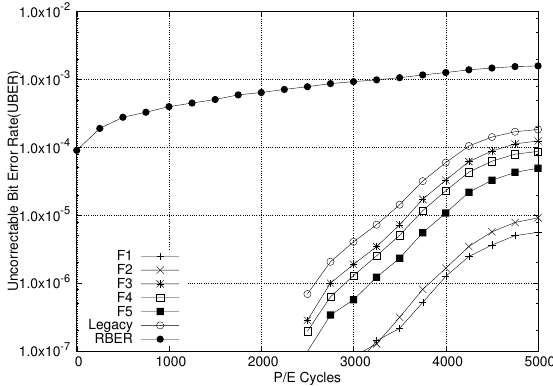
Figure 8. Adaptive ECC scheme for IO traces from F-1 to F-5 in comparison with